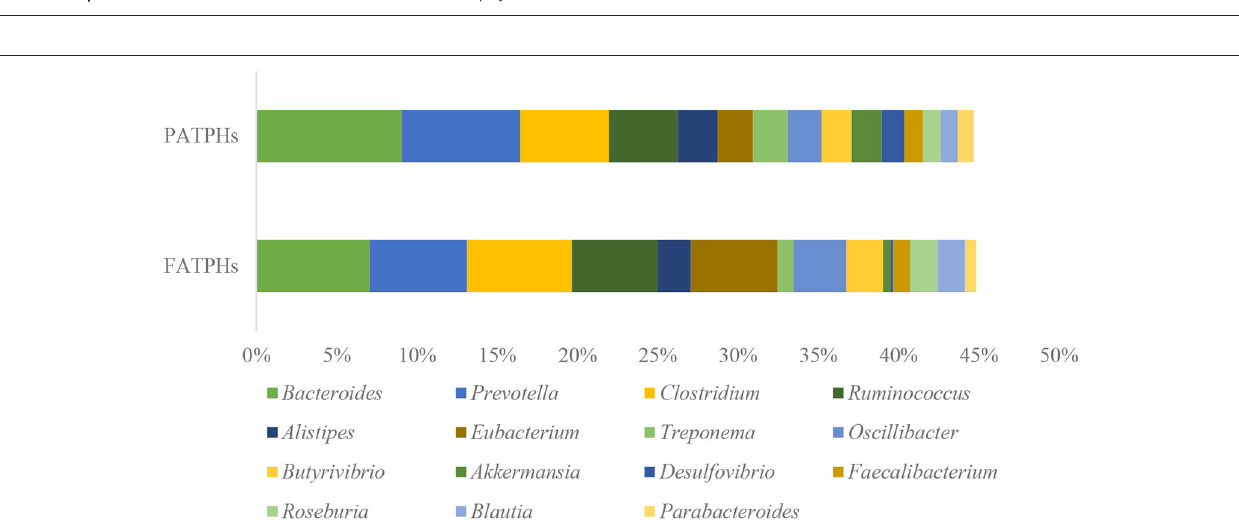
FIGURE 3 | Relative abundances of the well classified bacterial phyla in FATPHs and PATPHs.